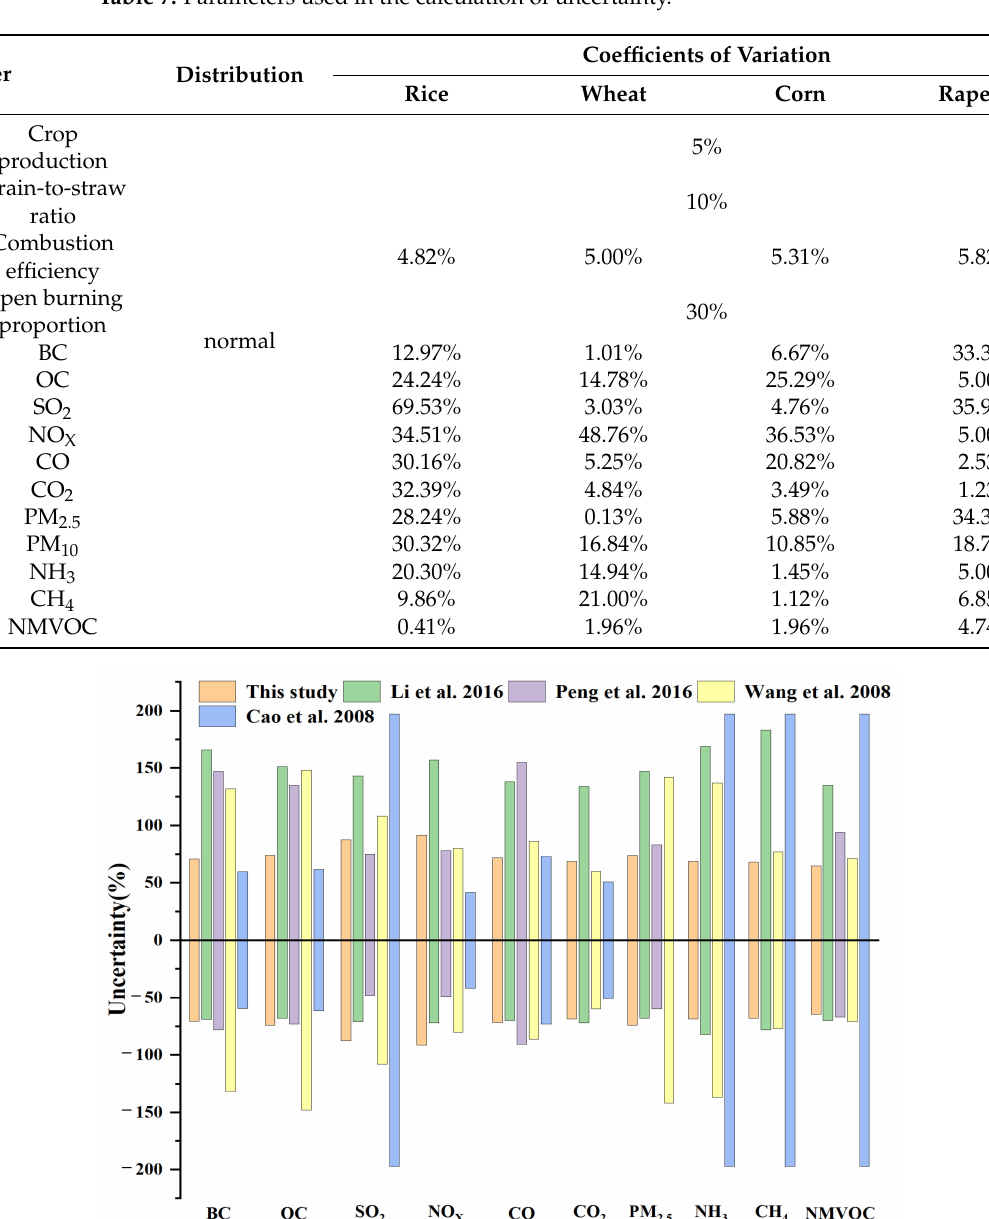
Table 7. Parameters used in the calculation of uncertainty.